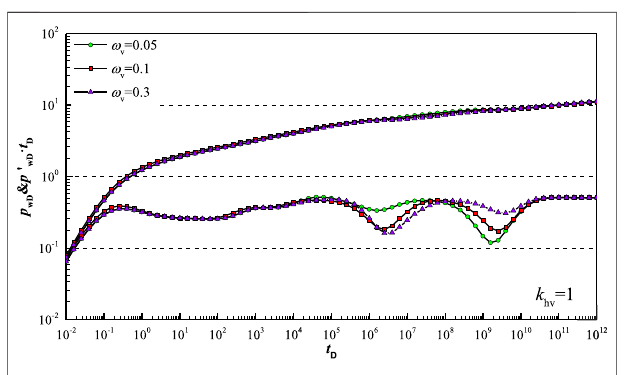
FIGURE 11 | Type curve affected by parameter ω f ( ω v (cid:2) 0 . 01 ) . ( C D (cid:2) 0 . 1 , S (cid:2) 0 . 1 , h (cid:2) 100 , h w (cid:2) 200 , r w (cid:2) 0 . 1 , θ w (cid:2) 60 o , k D (cid:2) 1 , κ (cid:2) 0 . 7 , λ mf